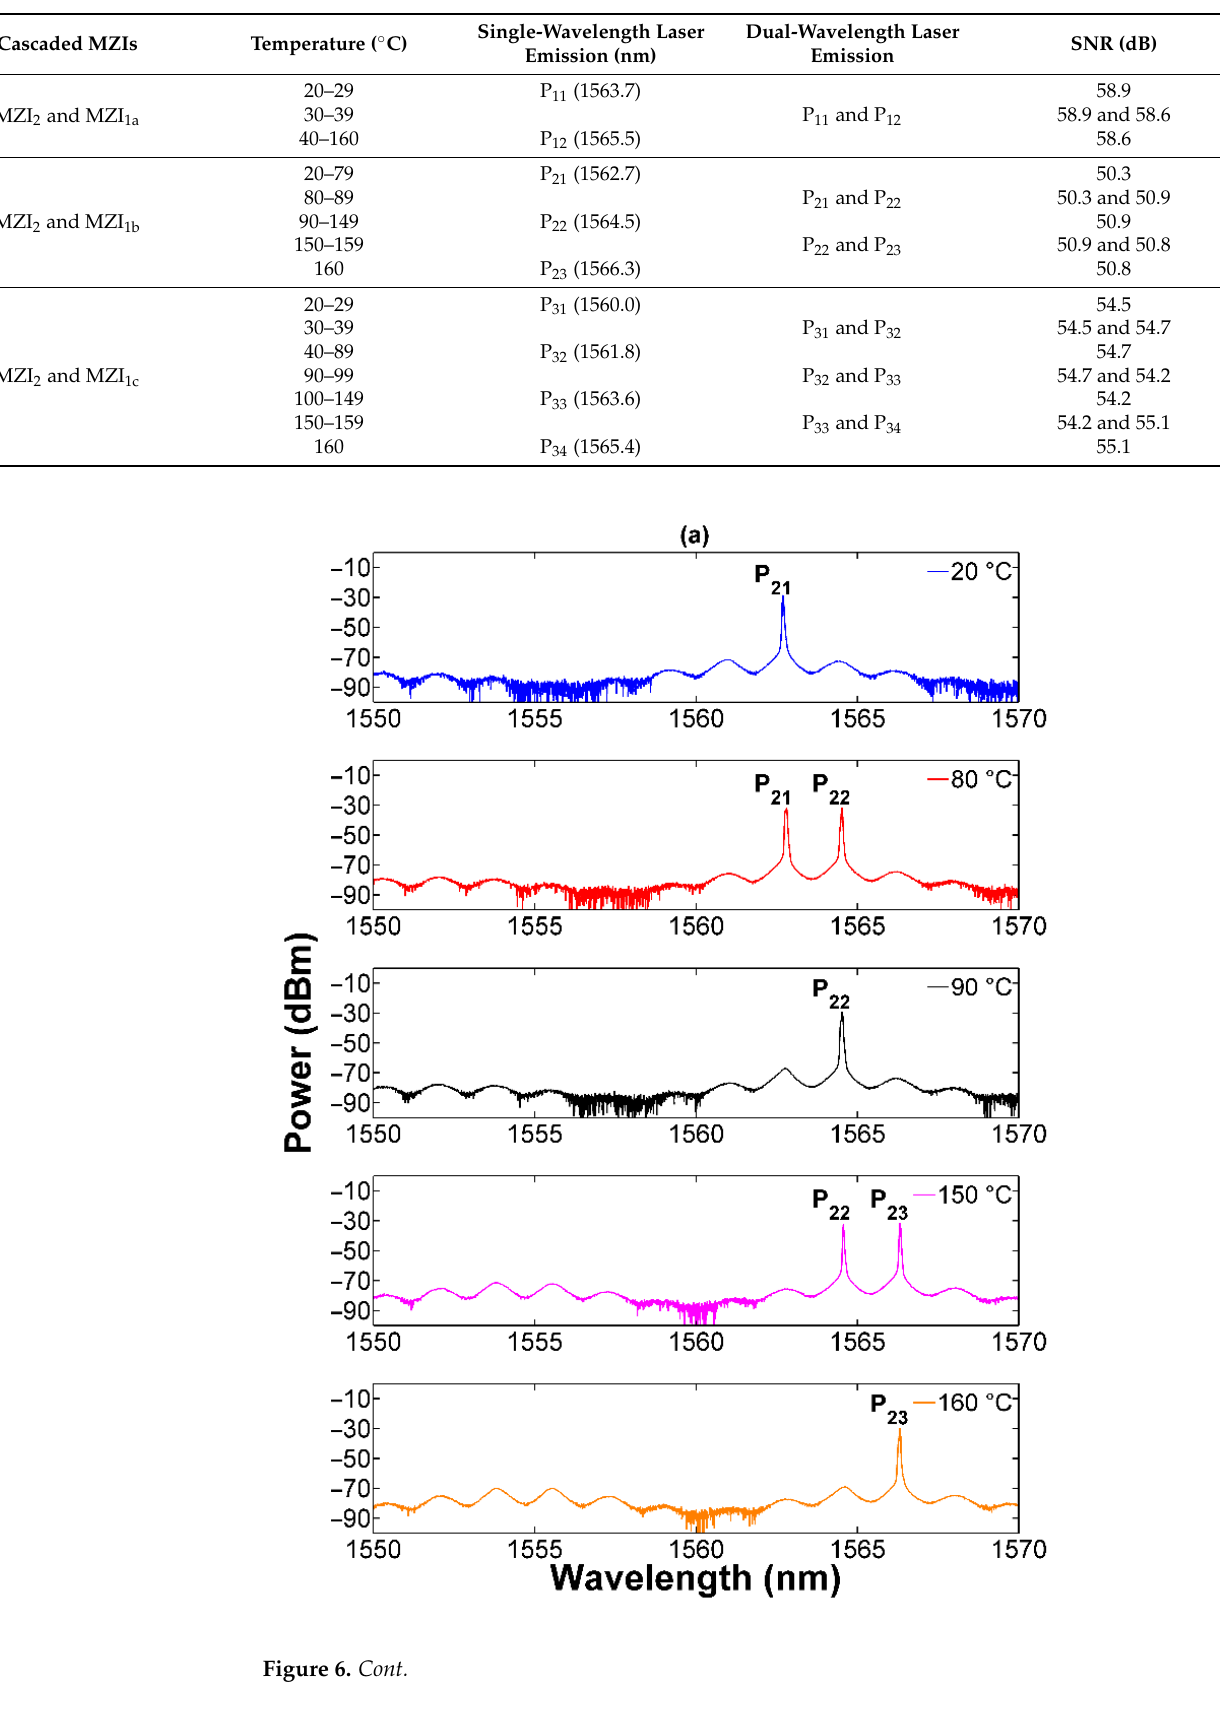
Table 3. Summarized results of the MZI 2 connected and cascaded with MZI 1 . Figure 5. Switchable operation of the EDFL using MZI 2 and MZI 1a in a cascade configuration, with-